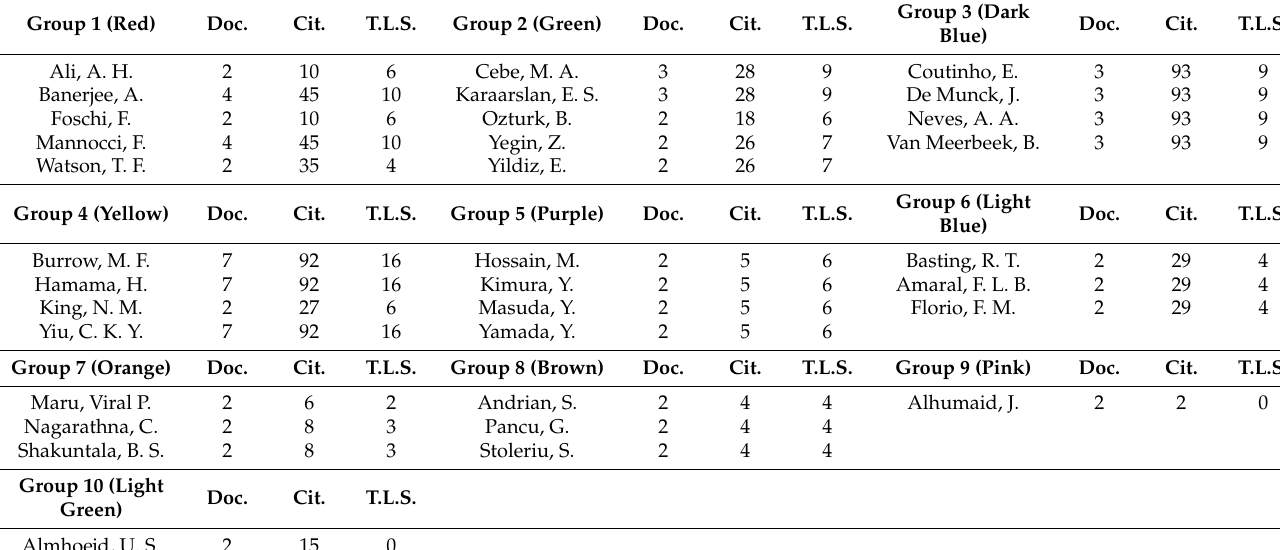
Table 2. Author groups and related number of documents and links. Source: own processing through VOSviewer.